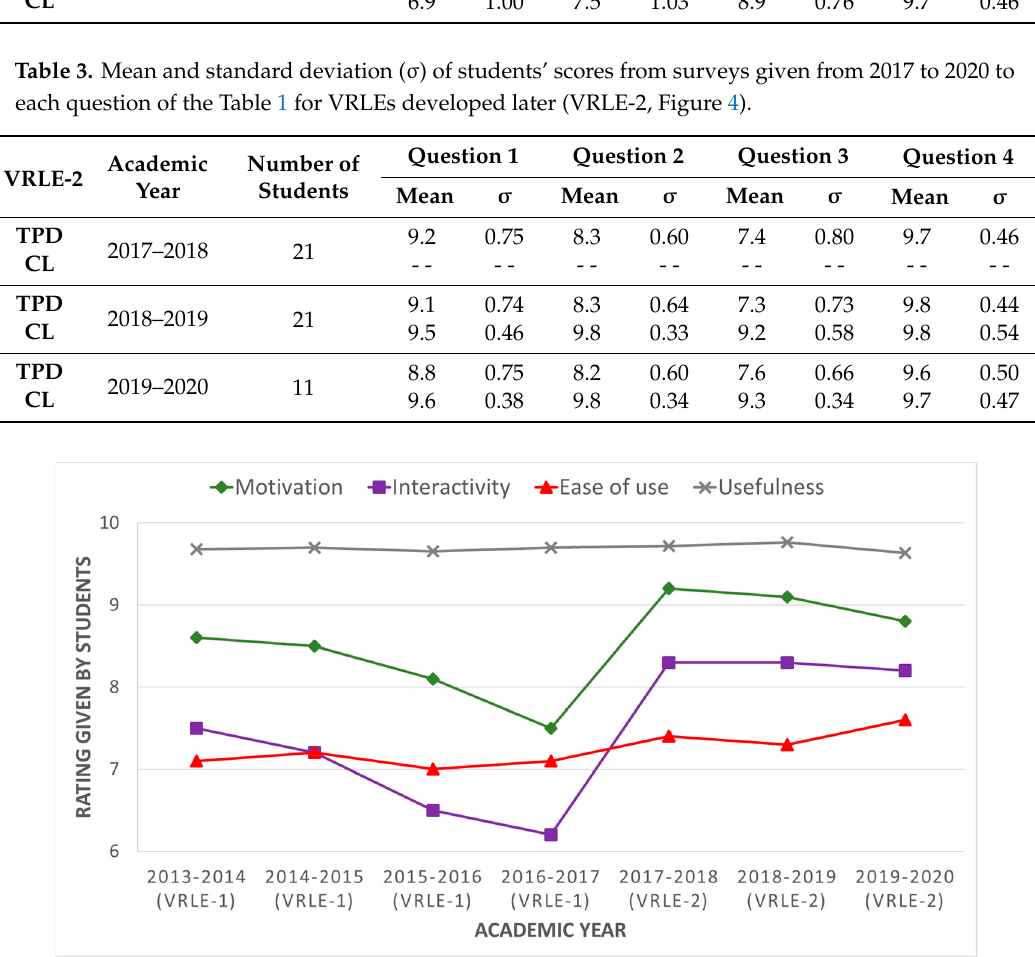
Table 3. Mean and standard deviation ( σ ) of students’ scores from surveys given from 2017 to 2020 to each question of the Table 1 for VRLEs developed later (VRLE-2, Figure 4).